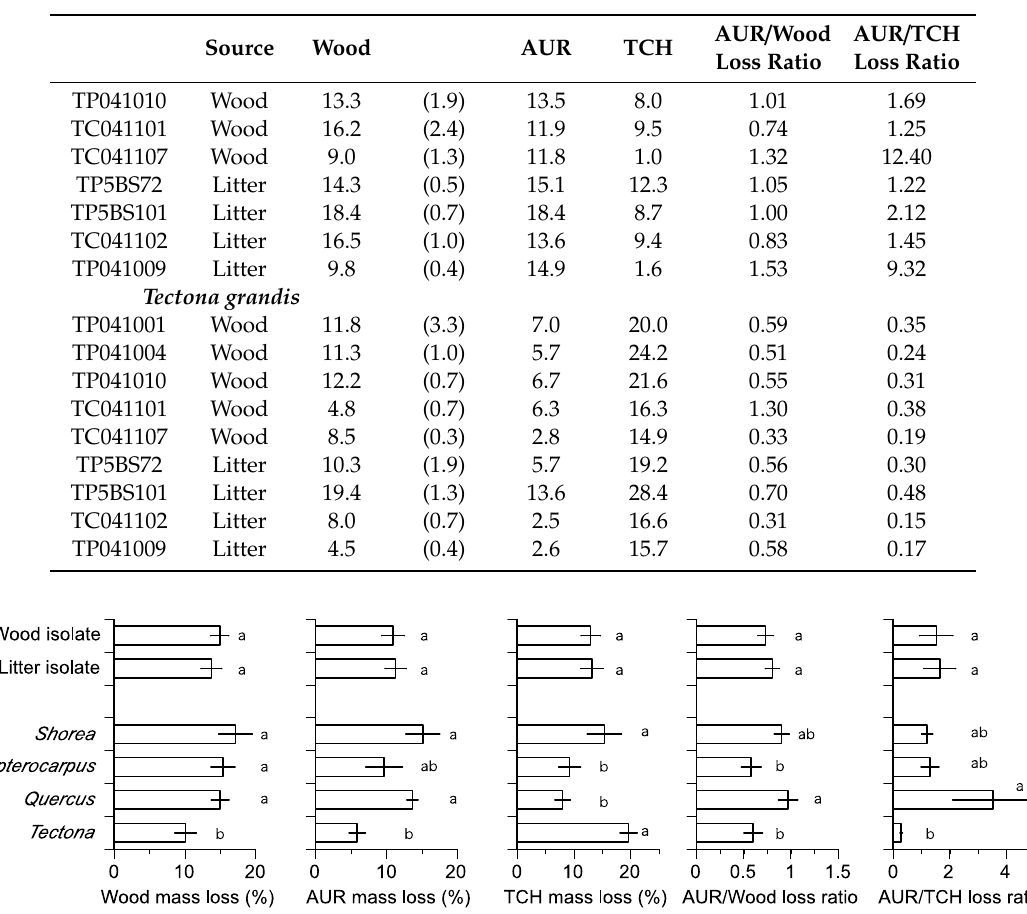
Figure 1. Mean values of mass loss for wood, acid unhydrolyzable residue (AUR), and total carbohydrates (TCH), AUR/wood loss ratio, and AUR/TCH loss ratio. The same letters indicate that there is not a significant difference at the 5% level by Tukey’s HSD test. Bars indicate standard errors.